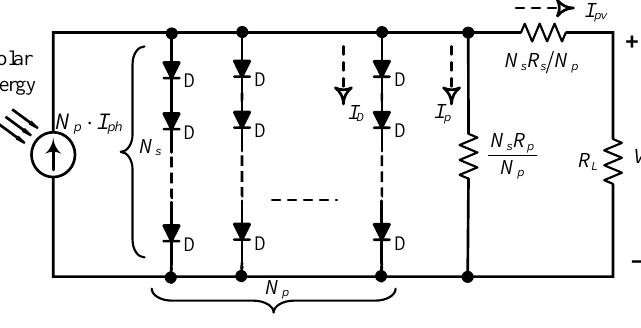
Figure 1. Equivalent model of a PV array. For the standalone PV power system, the PV panels are connected in a parallel and series configuration. In the case of uniform PV illumination intensity, all PV panels will emit the same current and voltage. As shown as the black P-V curve in Figure 2, only one power peak appears on the P-V curve, where it is easily found by traditional MPPT methods as well as modern MPPT methods. In contrast, when the illuminance intensity on the PV panels is not uniform, the P-V curve will have many power peaks, e.g., the red and green P-V curves as shown as in Figure 2. In which there is one highest power peak called the global maximum power point, and the remaining peaks have smaller power values called local maximum power points. Since the partial shaded PV panels only provide low output currents, the overall efficiency is limited. Furthermore, each PV panel is parallel with a bypass diode, as an example shown in Figure 3. At that time, the bypass diode will conduct the current of the whole PV system to bypass the shaded PV panel which can only provide a lower limited current. As a result, the power of the PV system under the partial shading effect is improved. For example, when the illuminance intensity of the PV panels in Figure 3 are distributed in 100 2 / mW cm , 75 2 / mW cm , 45 2 / mW cm , the PV output current and output voltage have the relationship given in Table 2, where Table 2. Relationship between the output voltage and current under partial influences. respectively, are the short-circuit currents satisfying . In other words, the Cases of shaded PV panel may be isolated for some cases of load currents. This induces multiple power peaks in the P-V curve under partial shading influences as shown as Figure 2.